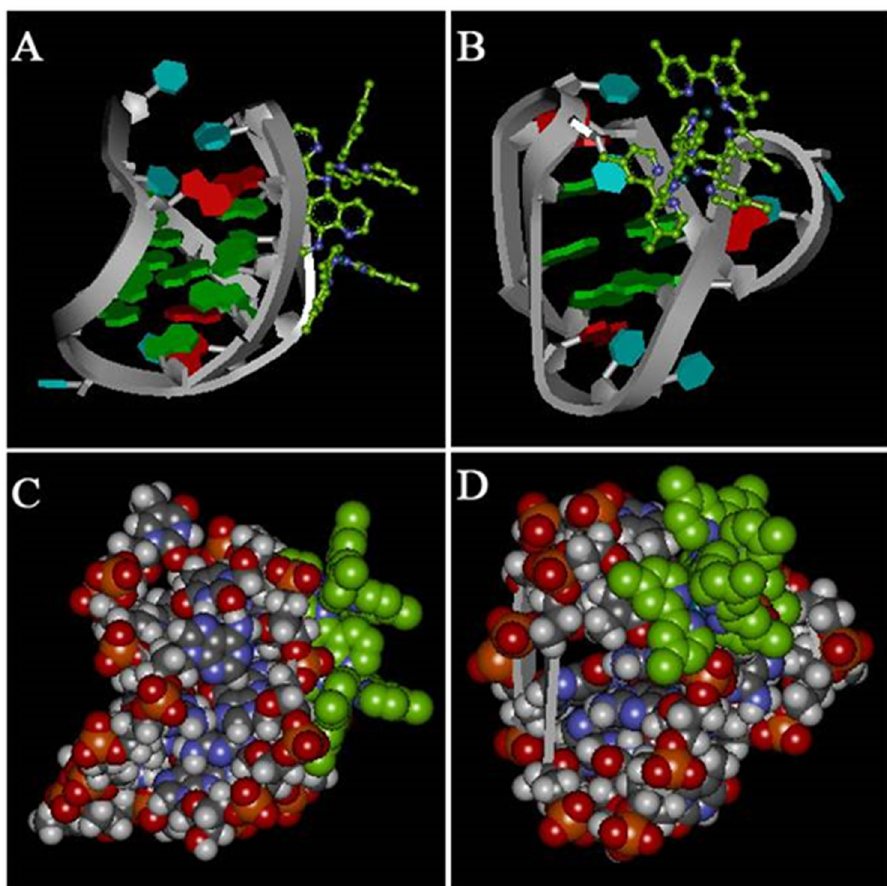
Figure 6. Binding modes assessed by molecular docking